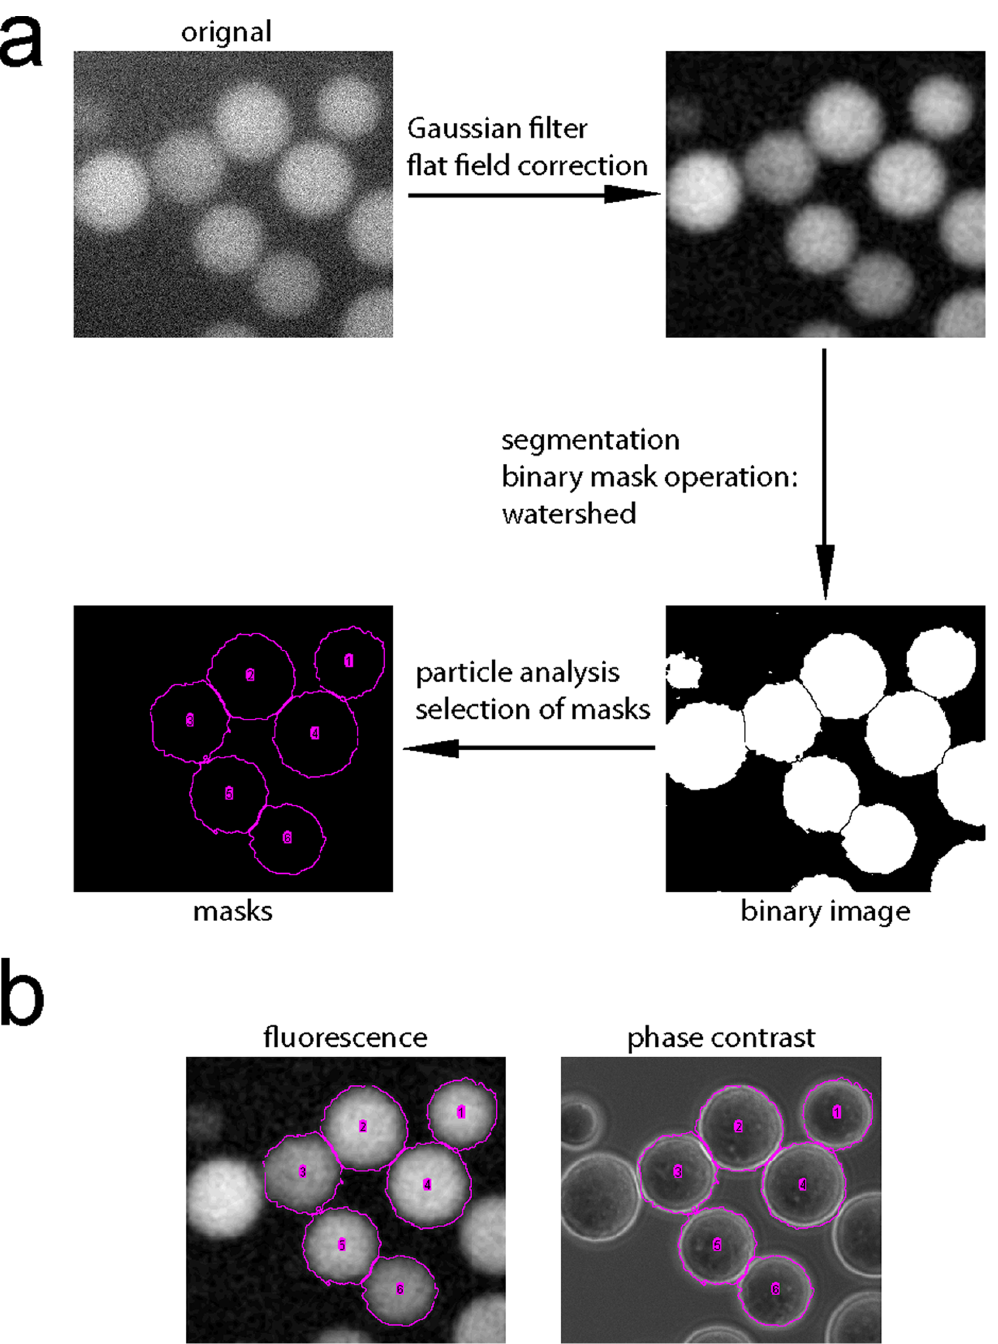
Figure 1. Generating masks for IBRP assay. (a) A method to mask individual beads using ImageJ. The masks are shown as magenta circles labeled with numbers. (b) The resulted masks are overlaid onto fluorescence and phase contrast images of the same beads. The masks are found to match the physical contour of the corresponding beads.